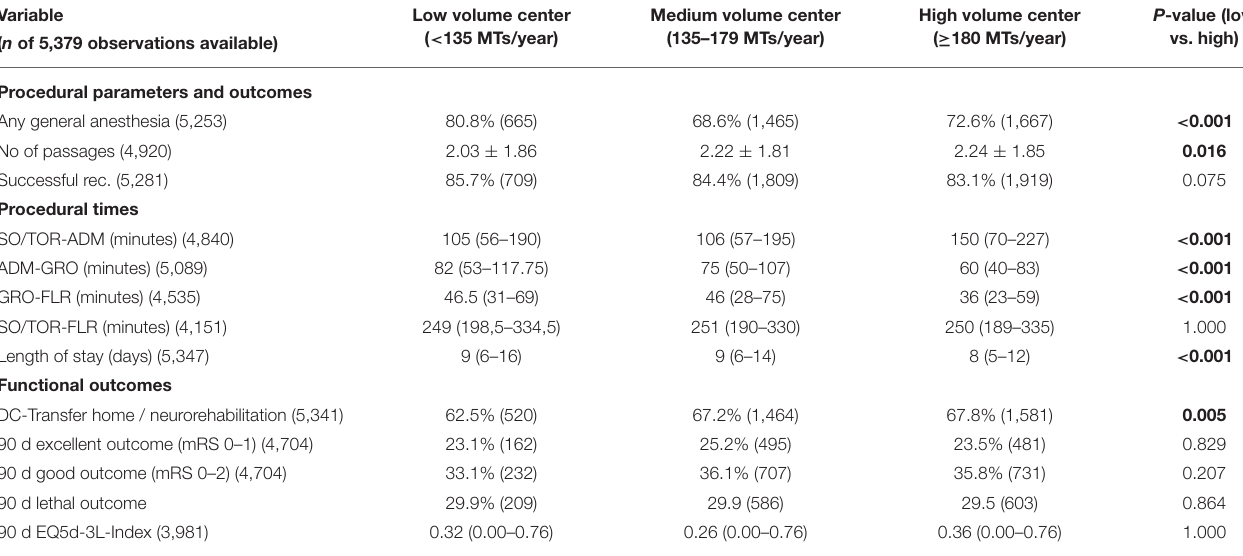
TABLE 2 | Univariate analysis of procedural and functional outcomes of patients treated in “low-volume centers” compared with “medium-” and “high-volume centers.” Variable Low volume center